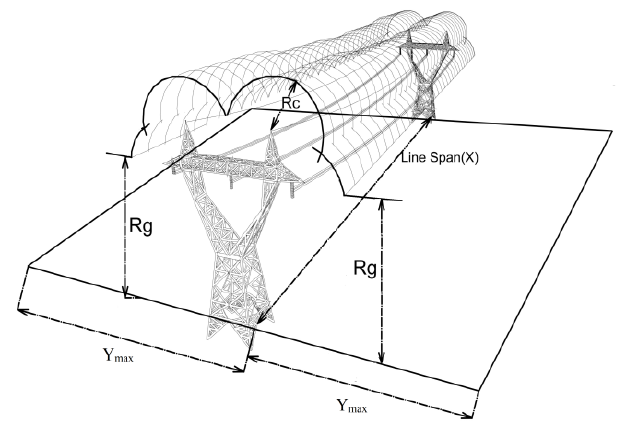
Figure 3: Insulator string model of TL .